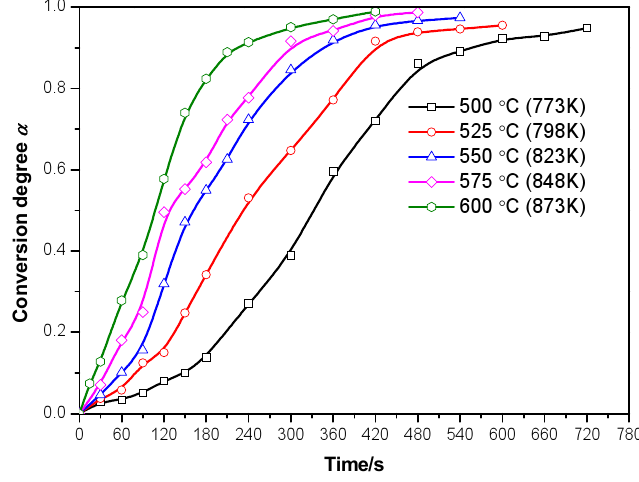
Figure 4. Conversion degree α vs. time for the selected process temperatures.